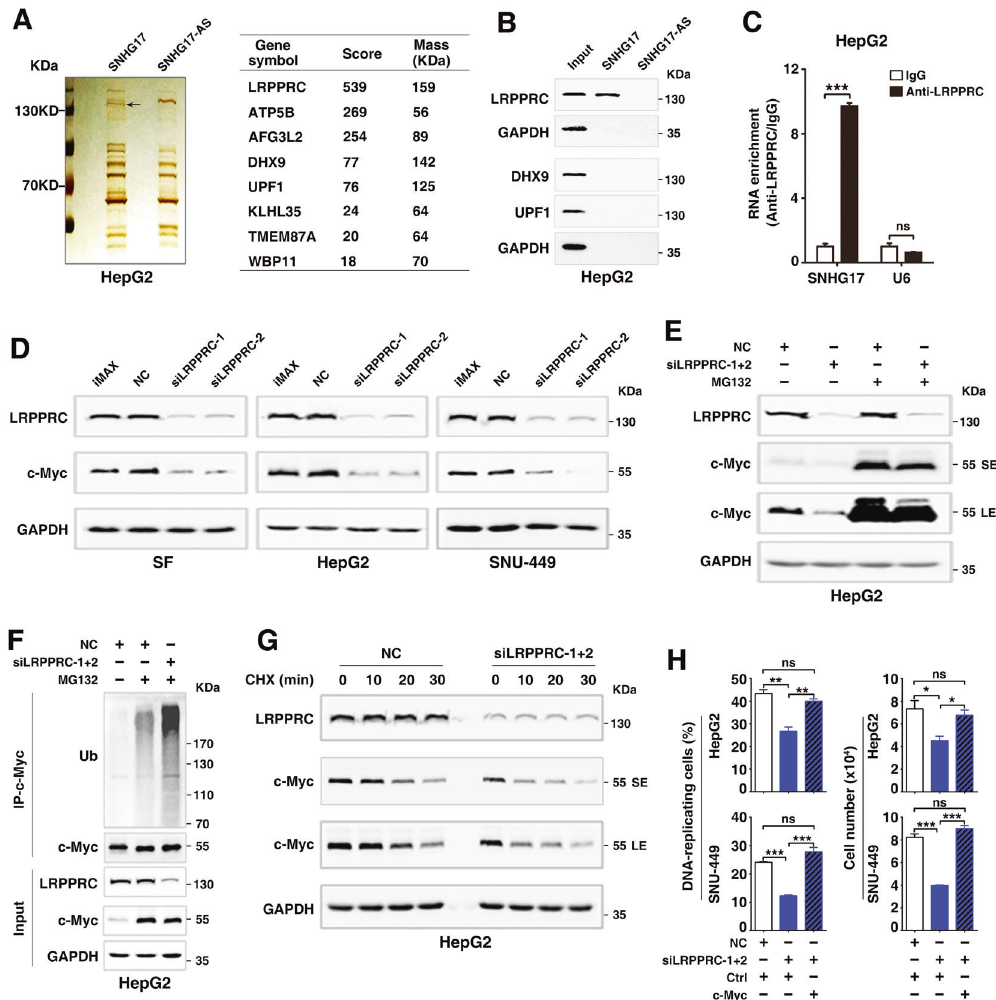
Fig. 5 LRPPRC interacts with SNHG17 and promotes G1/S transition by increasing the stability of c-Myc protein. A Identi fi cation of SNHG17-associated proteins by RNA pulldown and mass spectrometry assays. Biotin-labeled SNHG17 or its antisense RNA (SNHG17-AS, negative control) was incubated with lysates from HepG2 cells to pull down the SNHG17-associated proteins, followed by silver staining. A speci fi c fragment (indicated by an arrow), pulled down by SNHG17 but not SNHG17-AS (left panel), was subjected to mass spectrometry. The candidate proteins are listed (right panel). B LRPPRC but not DHX9 or UPF1 was enriched in the protein complexes pulled down by SNHG17. Cellular proteins were pulled down with biotin-labeled SNHG17 or SNHG17-AS and then subjected to Western blotting. GAPDH, negative control. C RNA immunoprecipitation assays revealed an interaction between SNHG17 and LRPPRC in vivo. The RNAs that were precipitated by anti-LRPPRC antibody or isotype-matched control IgG were analyzed by qPCR, using primers for SNHG17 or U6. The enrichment was normalized to the IgG control. U6 was used as a negative control. D Silencing LRPPRC decreased the protein level of c-Myc. E The siLRPPRC-induced c-Myc reduction was abrogated by proteasome inhibitor. NC- or siLRPPRC-transfectants without ( − ) or with ( +